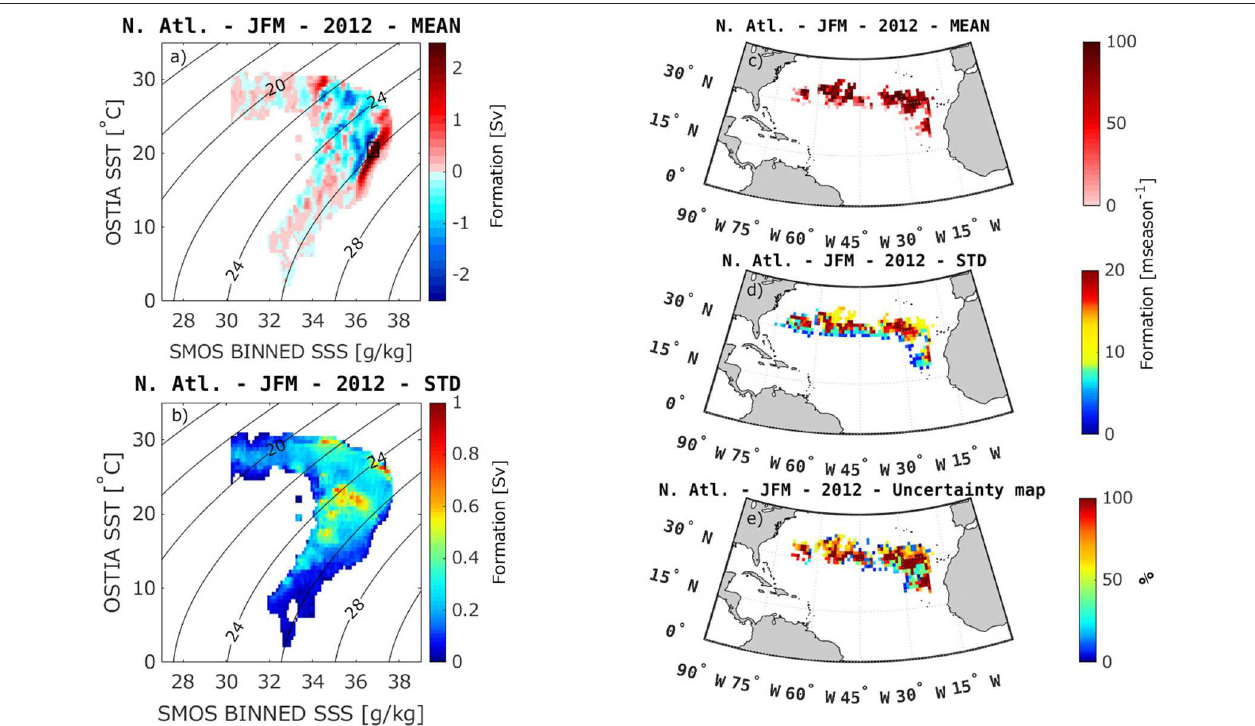
FIGURE 11 | Mean and standard deviation of formation averaged over the North Atlantic during winter (JFM) in 2012 using 500 Monte-Carlo realisations. Mean and standard deviation of formation in θ –S space (a,b) and geographic space (c,d) is shown along with the uncertainty in the geographic extent of formation (e) .